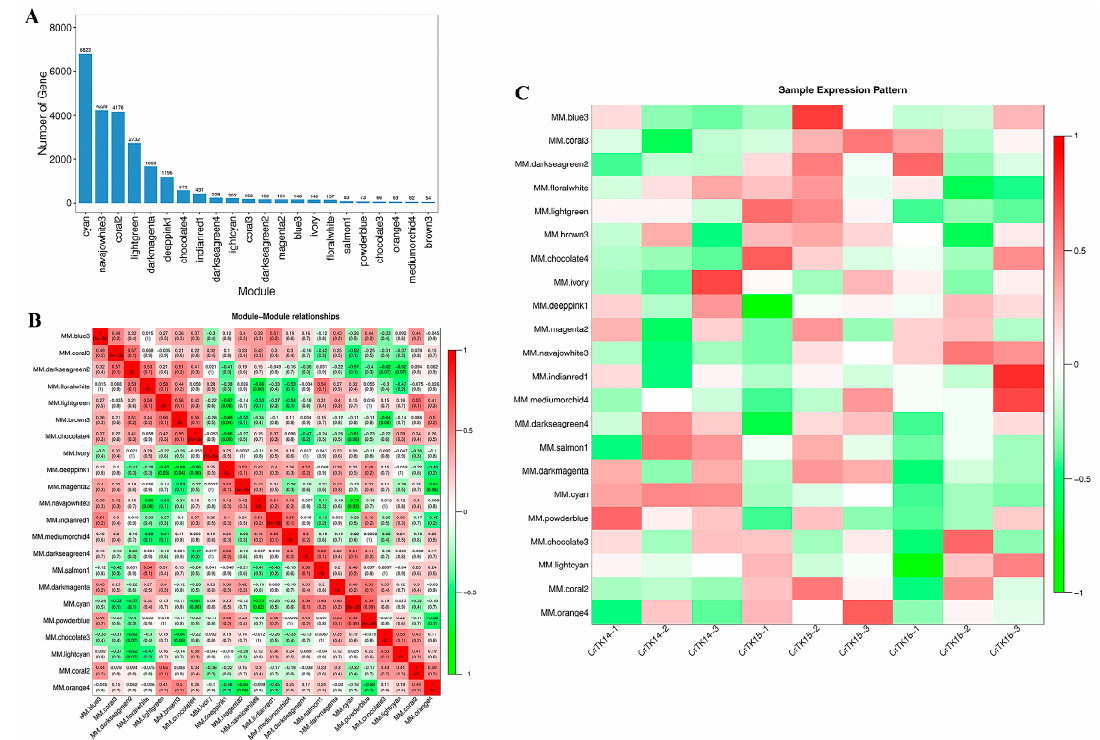
Figure 9. Weighted gene co-expression network analysis (WGCNA) of M. reevesii . ( A ) Twenty-two gene modules of M. reevesii . The X -axis represents the gene module name, and the Y -axis represents the number of each module. ( B ) Relationships among the modules. Red represents a positive relationship, and green represents a negative relationship. ( C ) Analysis of the relationship of the gene modules and the CR samples. Each row represents a gene module, and each column represents a sample. Red represents a positive relationship, and green a represents negative